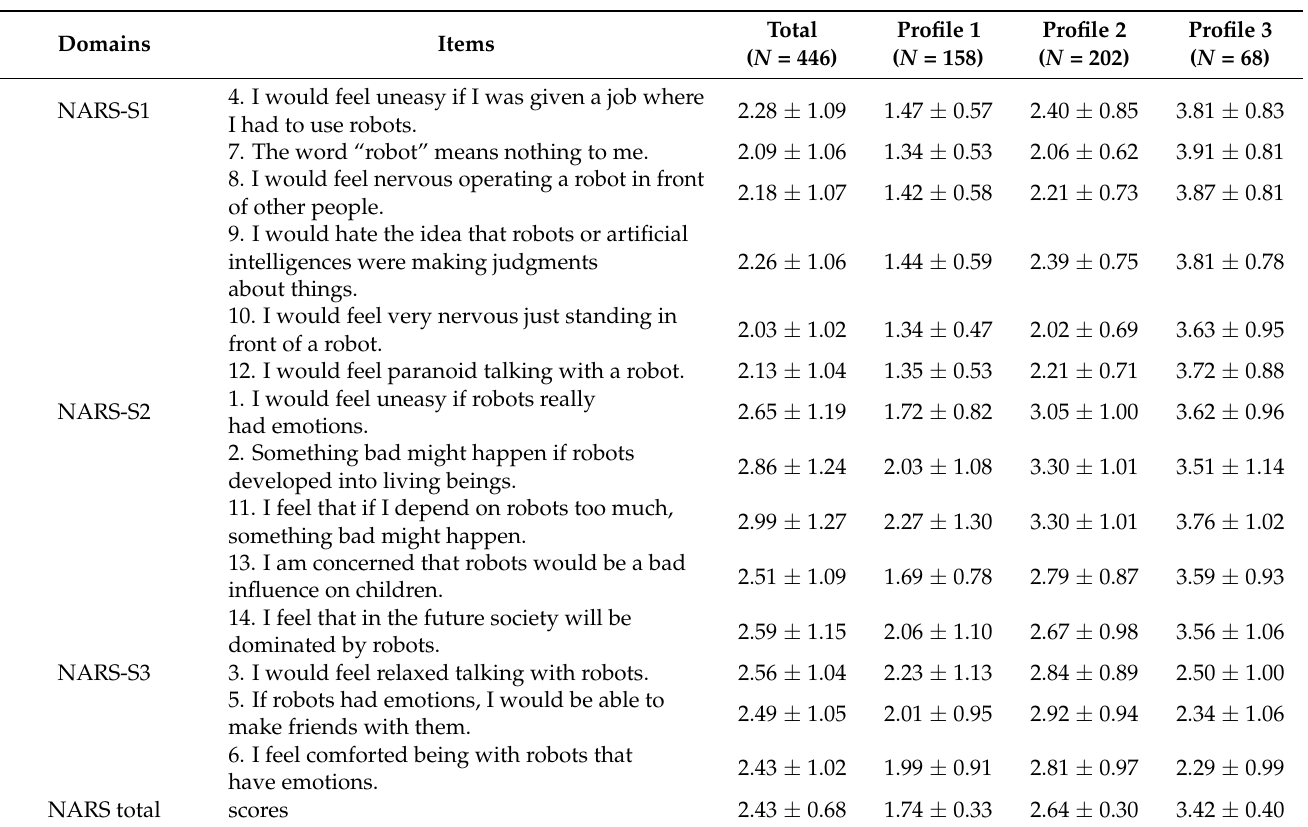
Table 3. NARS scores of the three